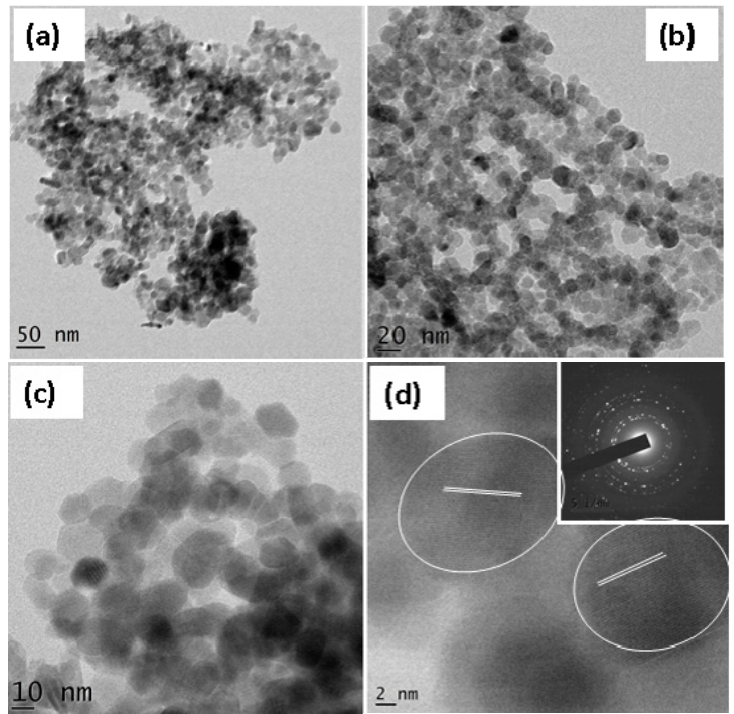
Figure 9. ( a – c ) TEM and ( d ) HRTEM (Inset: SAED pattern) images of the CeO 2 -ZnO nanocomposite.